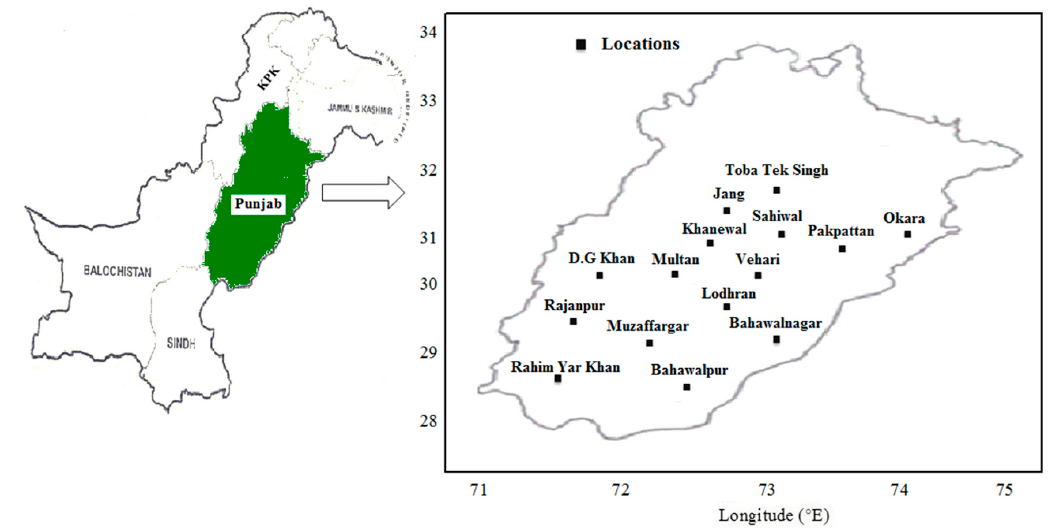
Figure 8. Map showing study locations in Punjab, Pakistan.